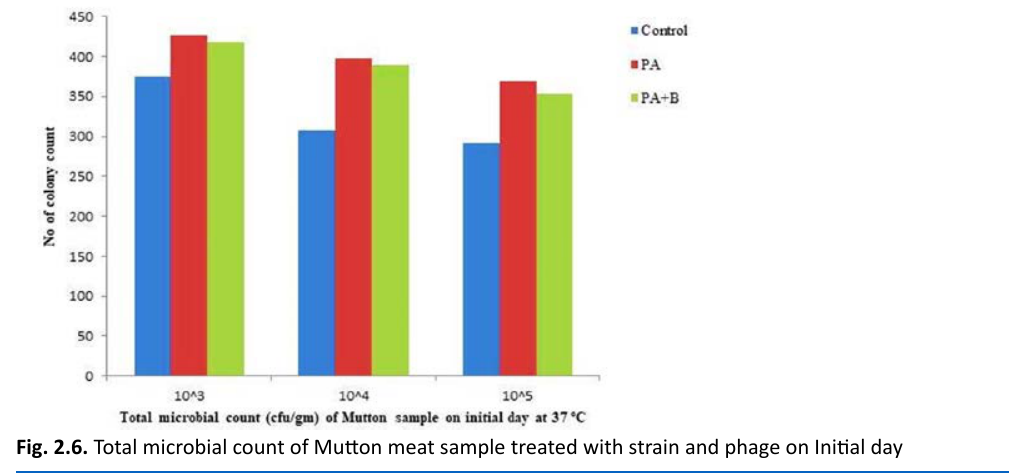
Fig. 2.5. Total microbial count of Chicken meat sample treated with strain and phage on 4 th day of Incubation at -20 °C.